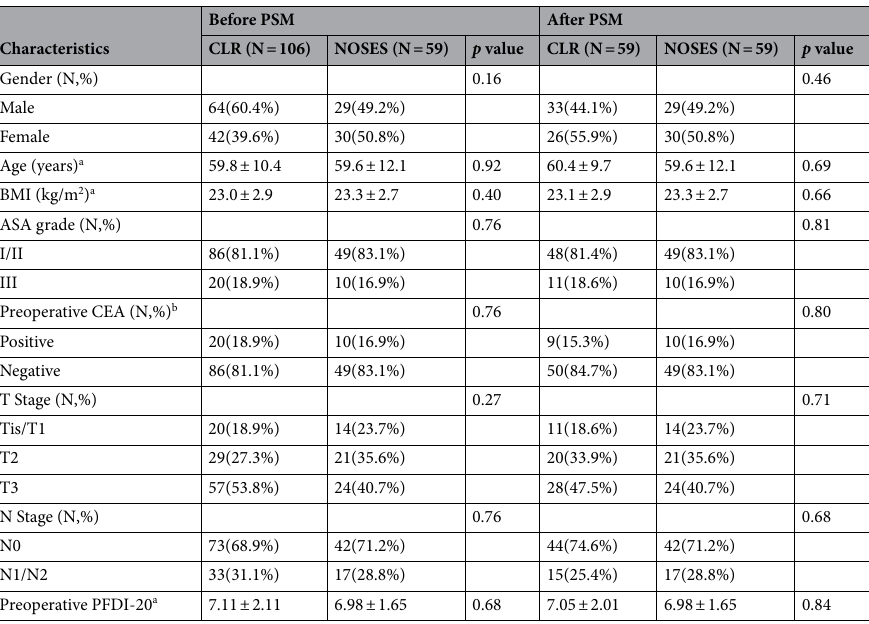
Table 1. Baseline information for two groups of patients. a Mean ± SD. b The cut-off value was considered to be 5